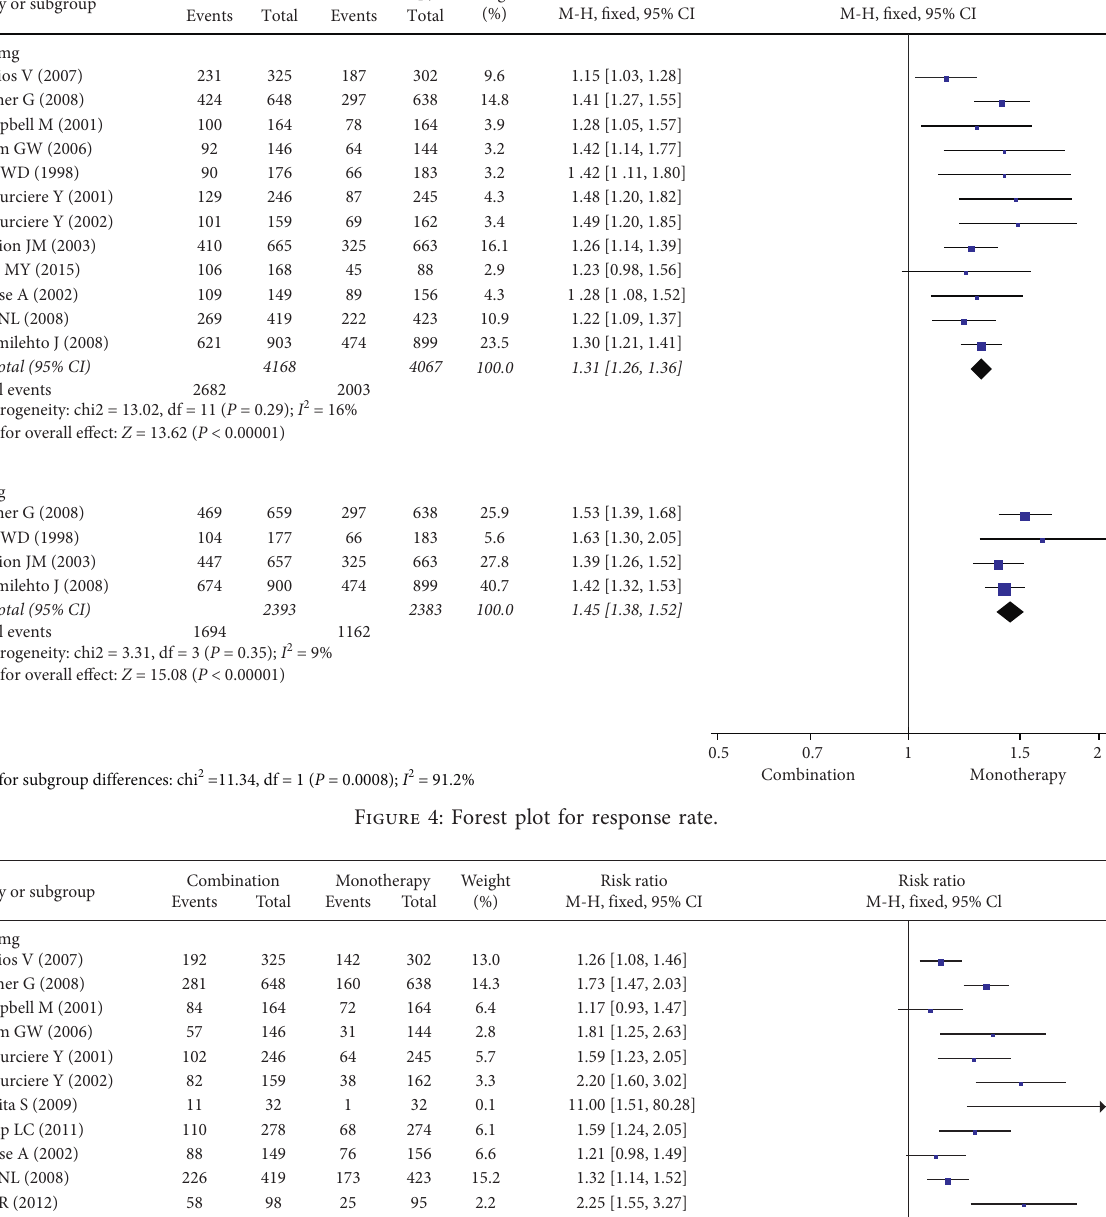
ClStudy or subgroup